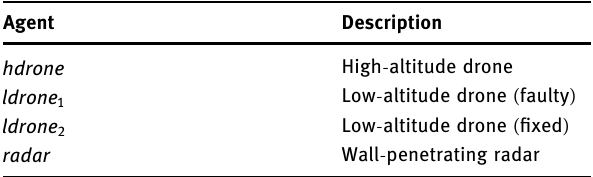
Table 1: AI agents in the